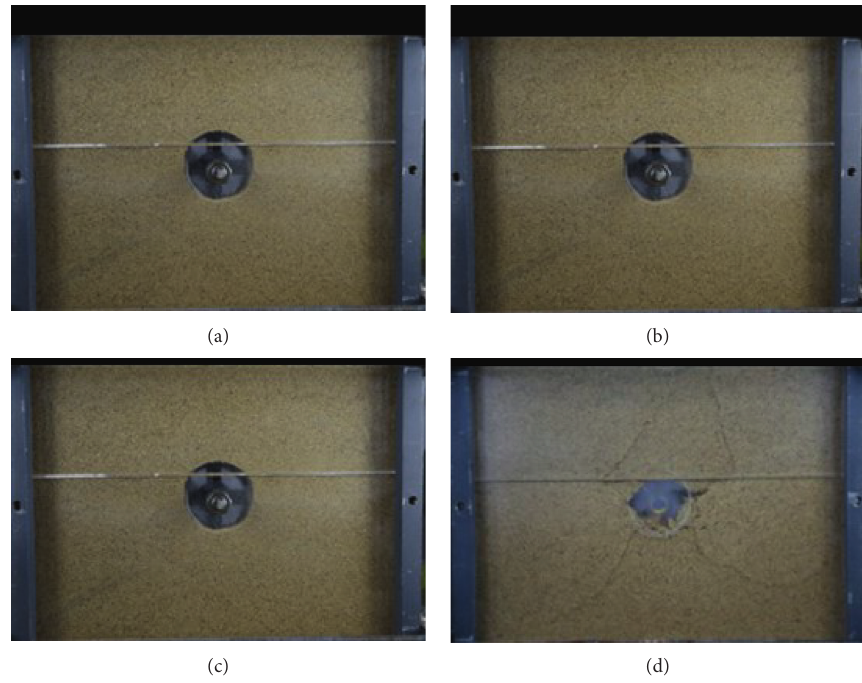
Figure 9: Main test image of unsupported mode. (a) 0.25MPa. (b) 0.40MPa. (c) 0.52MPa. (d) (Figure 10(f)), the surface displacement field of the tunnel presented an x -shaped fracture feature. The change of tunnel displacement was highlighted by the maximum at the top, and it decreased successively from the top to the two sidewalls.